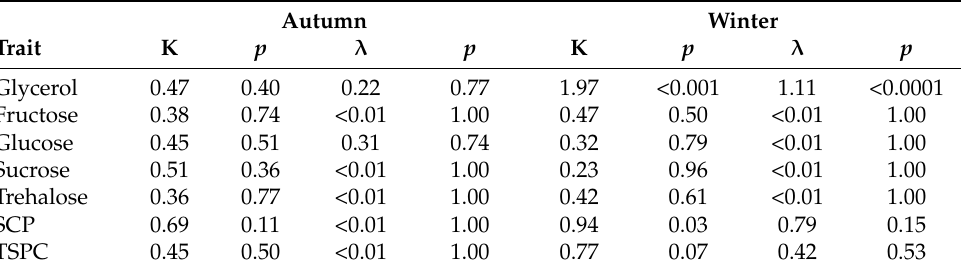
Table 3. Results of Blomberg’s K and Pagel’s λ testing the phylogenetic signal in major cryoprotectants, supercooling points (SCP) and total sugar and polyol concentrations (TSPC). See Appendix A for description of inference of the phylogenetic tree, and Figure 4 for mapping the traits onto the tree.